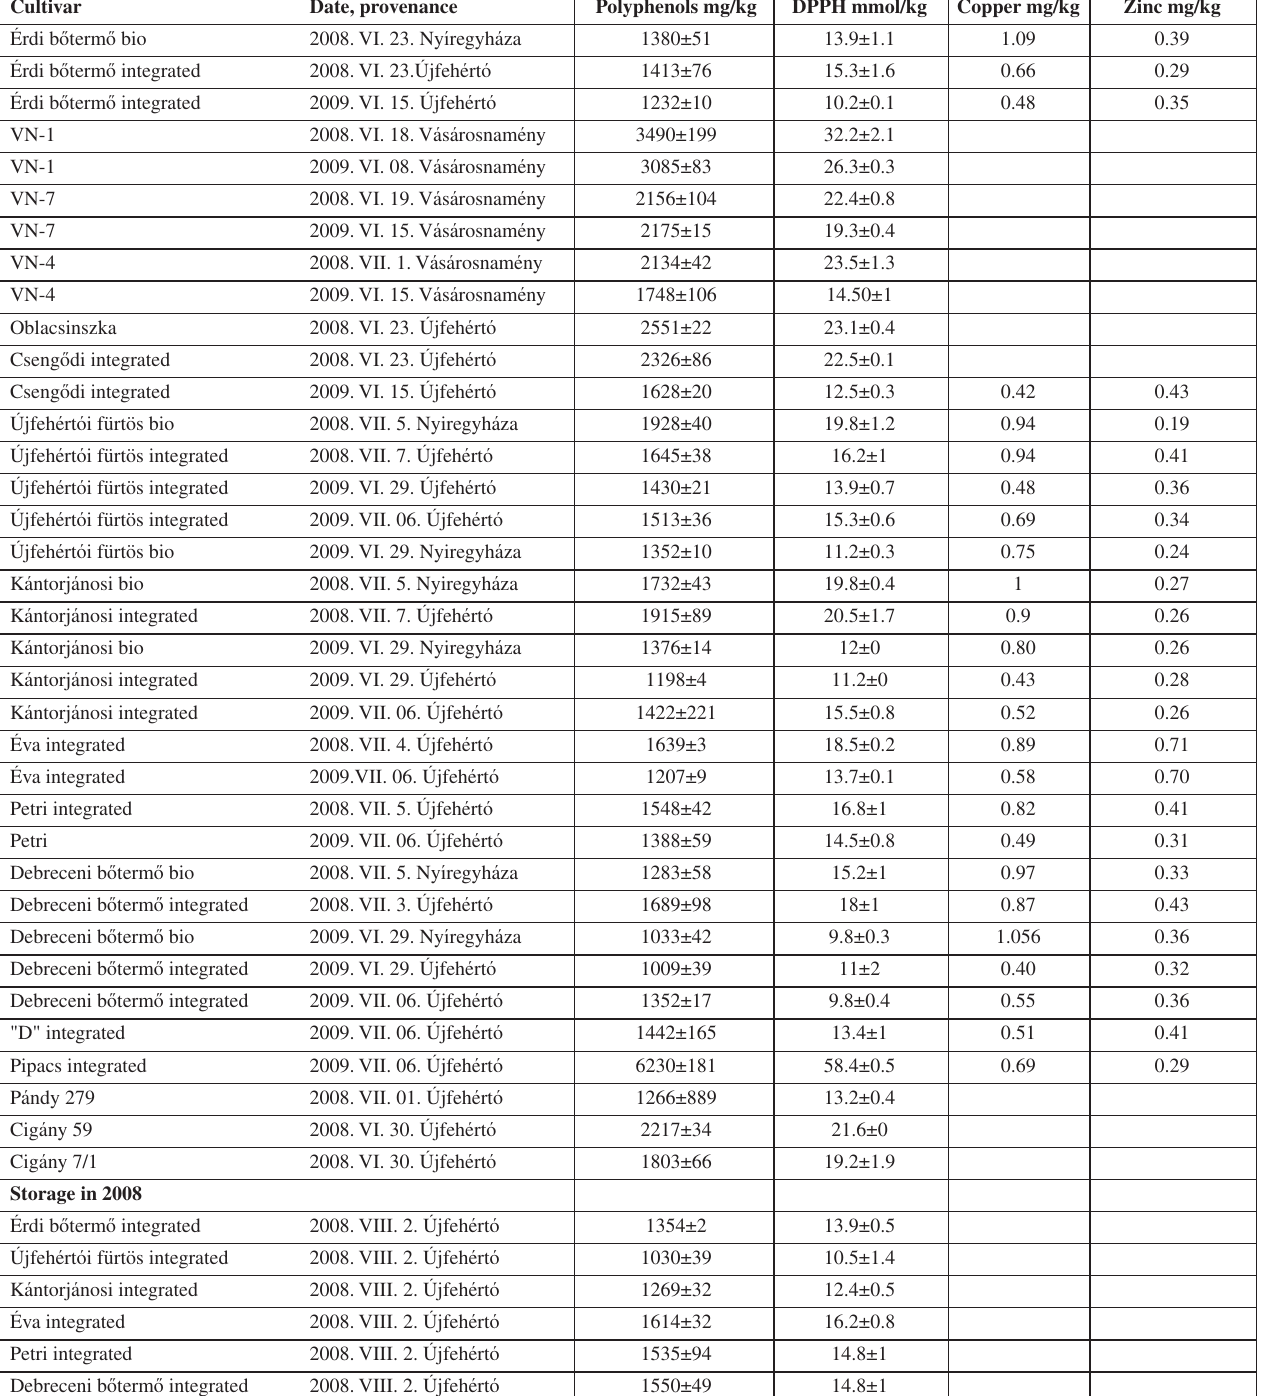
farming conditions at different provenances